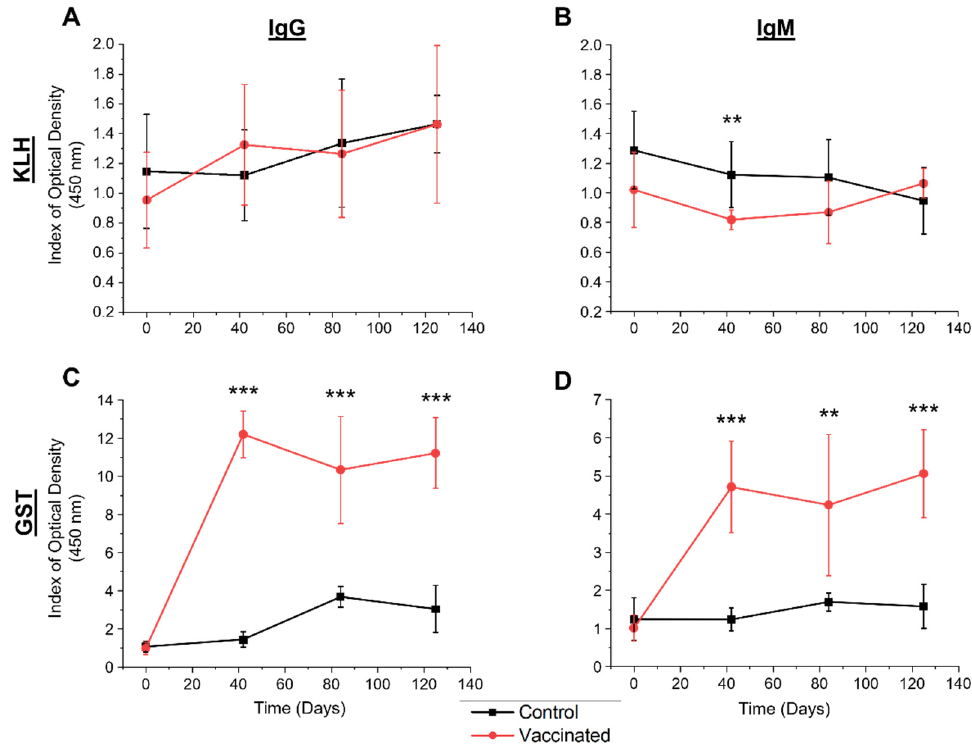
Figure 2. Humoral responses in study A to KLH and GST in the vaccinated and control groups as determined by ELISA. Bovine serum samples were analysed from days 0 (naïve, pre-vaccination), 42 (pre-challenge, post-vaccination), 84 (6 weeks post-challenge) and 125 (12 weeks post-challenge) for the control (black squares) and vaccinated (red circles) groups. Displayed are the indexes of the optical density for IgG ( A , C ) and IgM ( B , D ) for the natural antibody response towards KLH ( A , B ) and specific antibody response towards native F. hepatica GST ( C , D ), assessed four independent times. Results are expressed as the mean index of optical density (450 nm) for the group ( n = 6) +/ − the standard deviation (error bars) of the mean indexes. The vaccination group received native GST and a tegumental antigen at day 0 and 28 in Freund’s complete adjuvant (FCA) then Freund’s incomplete adjuvant (FIA), and the control group received saline injections in FCA/FIA. Both groups were then challenged on day 42 with liver fluke metacercariae and sacrificed 12 weeks after challenge. Any significant differences in means are noted (one-way ANOVA, ** = p < 0.001, *** = p < 0.001). Abbreviation: GST, native glutathione S -transferase.